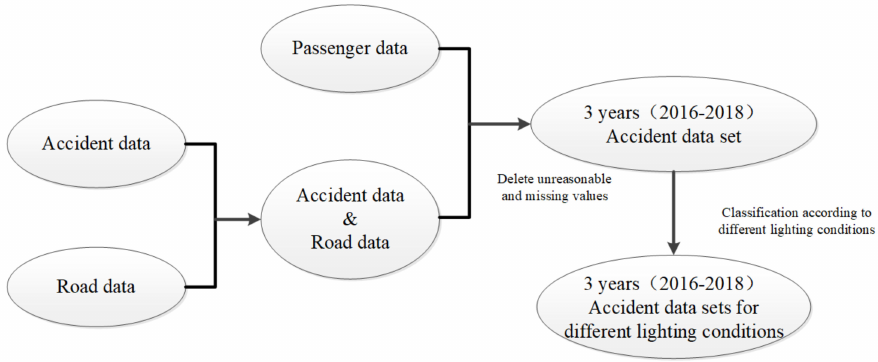
Figure 1. The flow chart of the data